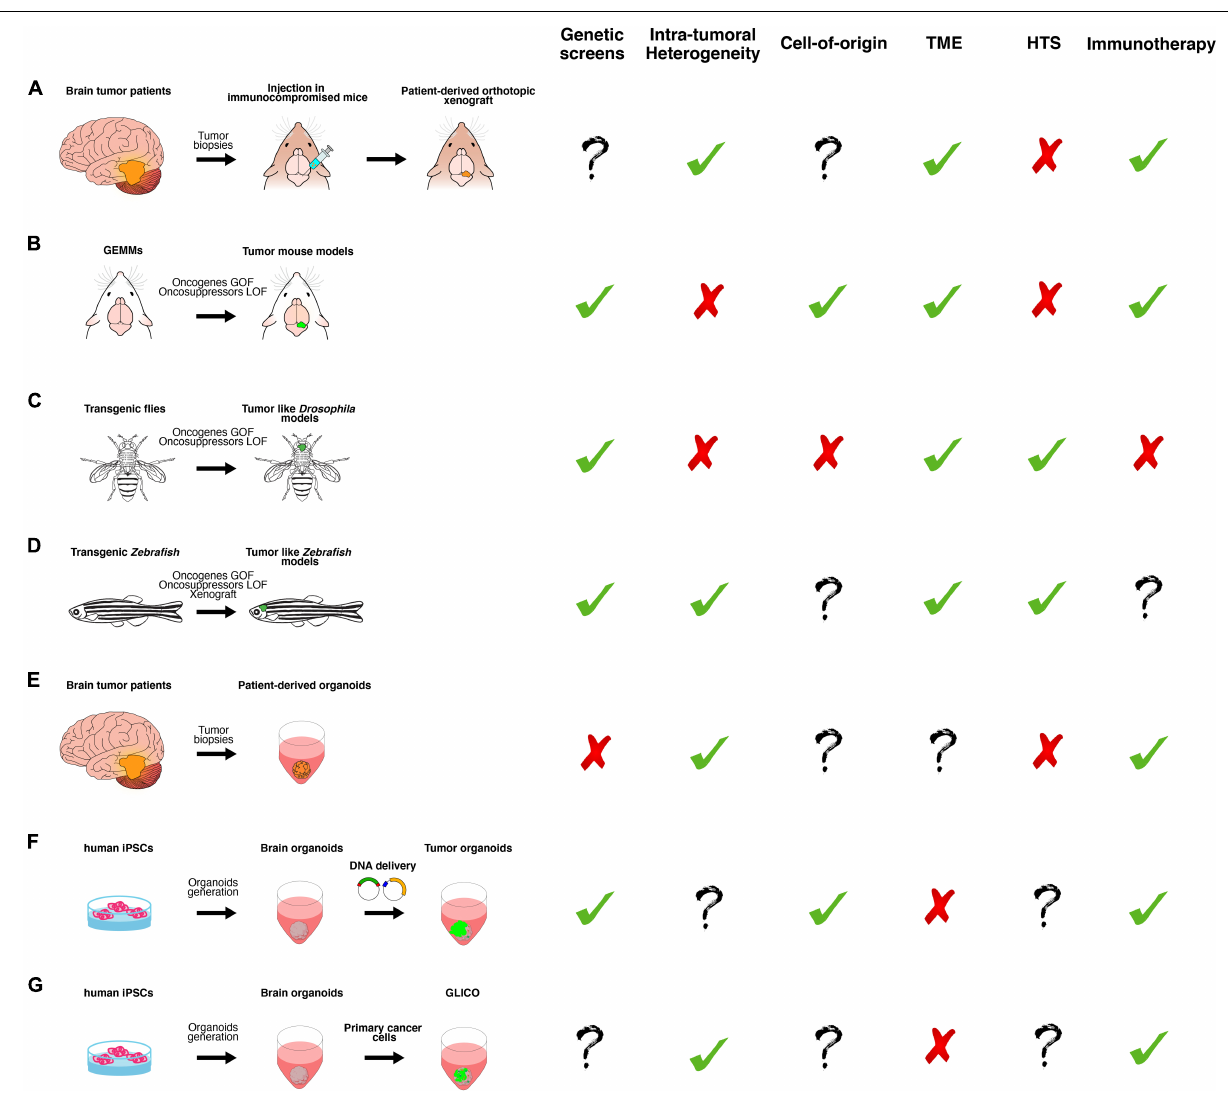
Nestin-CreER T2 ) (Llaguno et al., 2009), bipotential progenitors (i.e., Ascl1-CreER TM), oligodendrocyte progenitors (i.e., NG2- creER TM) (Llaguno et al., 2015) and immature ( NeuroD1- creER T2 ) or post-mitotic neurons ( CamKII α -creER TM) (Llaguno et al., 2019). Indeed, only neuronal stem cells (Nestin + or GFAP + cells) and early progenitors (Ascl1 + or NG2 + cells) that